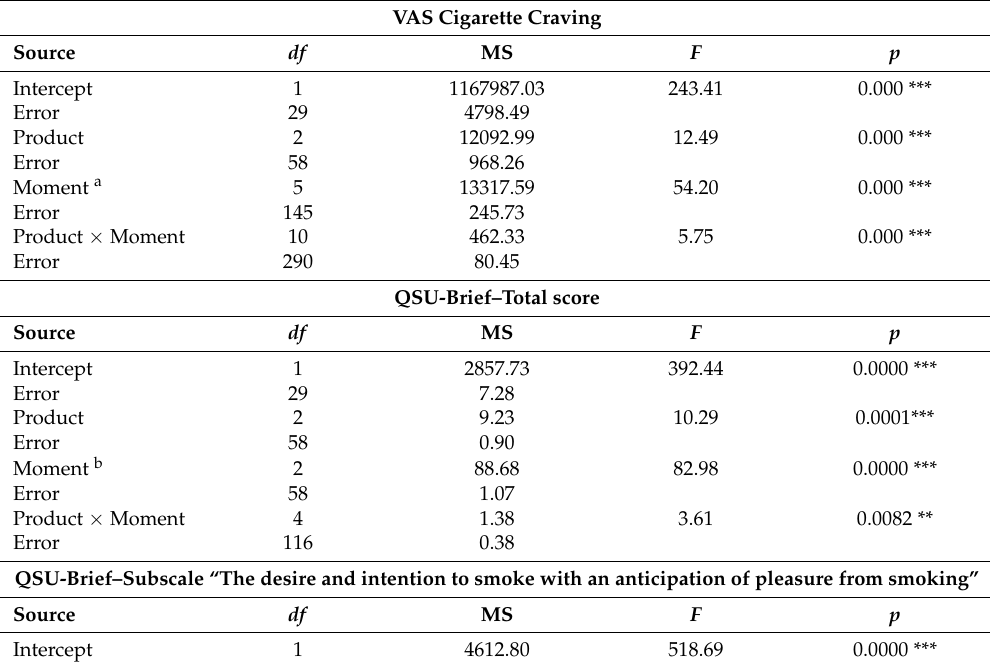
Table A3. ANOVA summary table for cigarette craving.